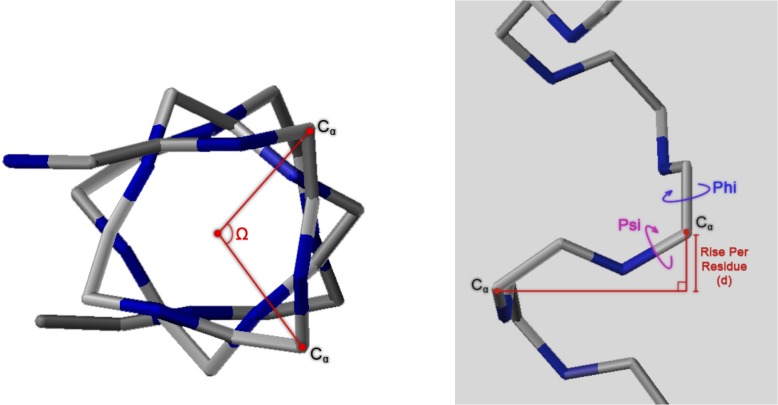
Definition of helical parameters with an oligopeptide helix backbone (nitrogens in blue).Left: Helix winding (Ω) is the angle between two adjacent Cα vectors (n = residues-per-turn/360). Right: Helix pitch (p) is the rise-per-residue, or vertical distance between Ω adjacent residues, projected on the helical axis.